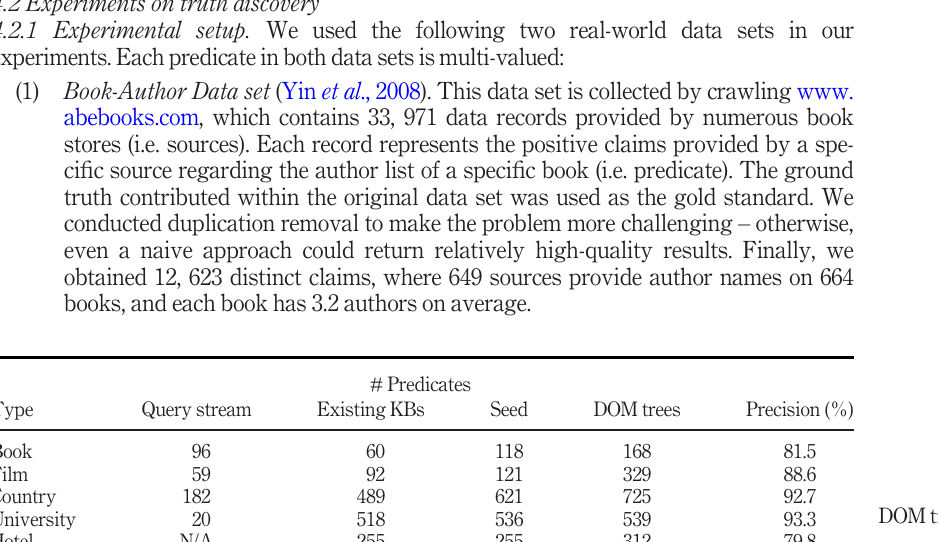
Table IV. DOM tree